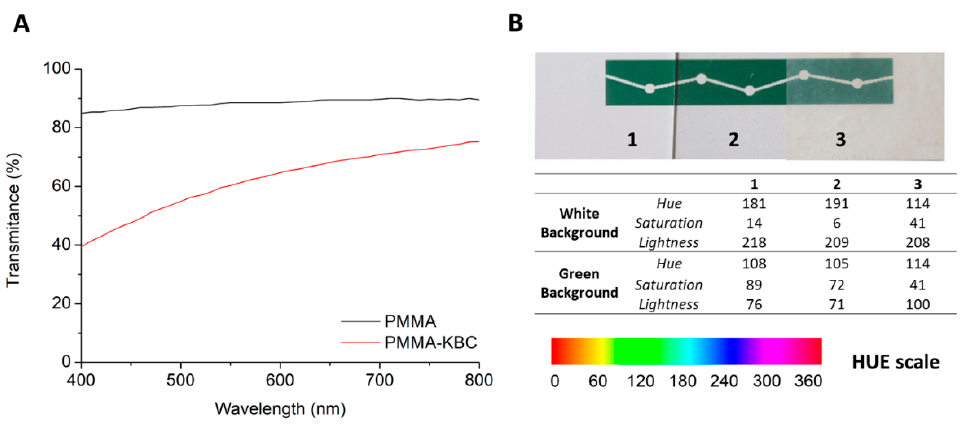
Figure 5. ( A ) VIS-transmittance of PMMA and PMMA-KBC nanocomposites. ( B ) Hue, Saturation, and Lightness (HSL) values of the control ( Left ) and HSL values after using PMMA film ( Middle ) and PMMA-KBC film ( Right ) as filters; the description of the numbers for the Hue scale are